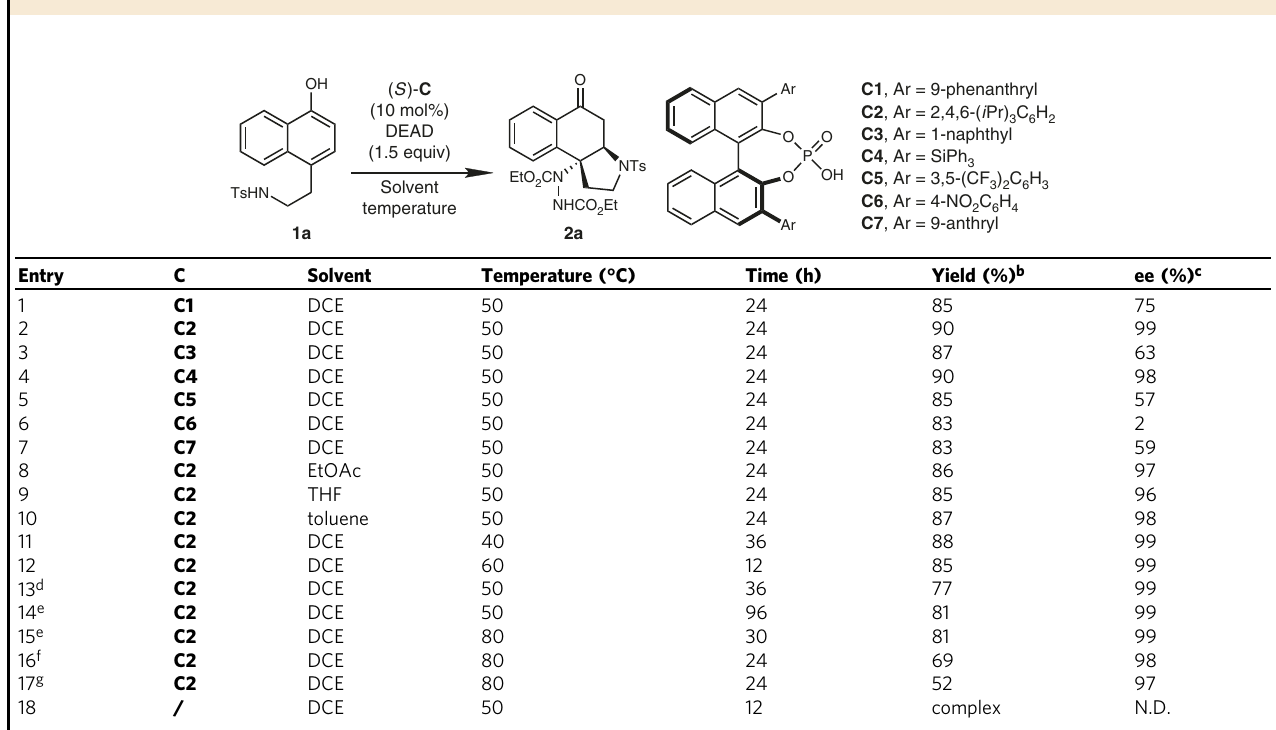
Table 1 Optimization of the reaction conditions